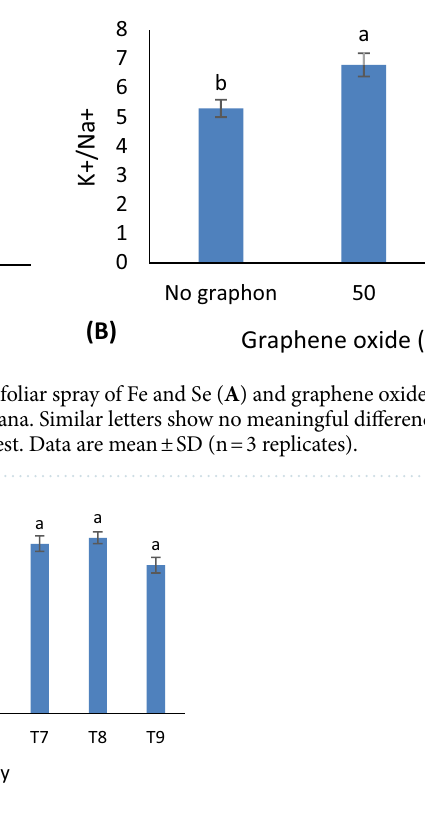
Figure 4. Mean comparisons for the effect of soil-based application of graphene oxide and foliar application with magnetic nano-iron and selenium under salinity on P content of grapevine cv. Sultana. Similar letters show no meaningful difference at 5% probability level by Duncan’s Multiple Range Test. Data are mean ± SD (n = 3 replicates). T1: NaCl 0 × Spray 0 , T2: NaCl 0 × Spray Fe , T3: NaCl 0 × Spray Se , T4: NaCl 50 × Spray 0 , T5: NaCl 50 × Spray Fe , T6: NaCl 50 × Spray Se , T7: NaCl 100 × Spray 0 , T8: NaCl 100 × Spray Fe , T9: NaCl 100 × Spray Se